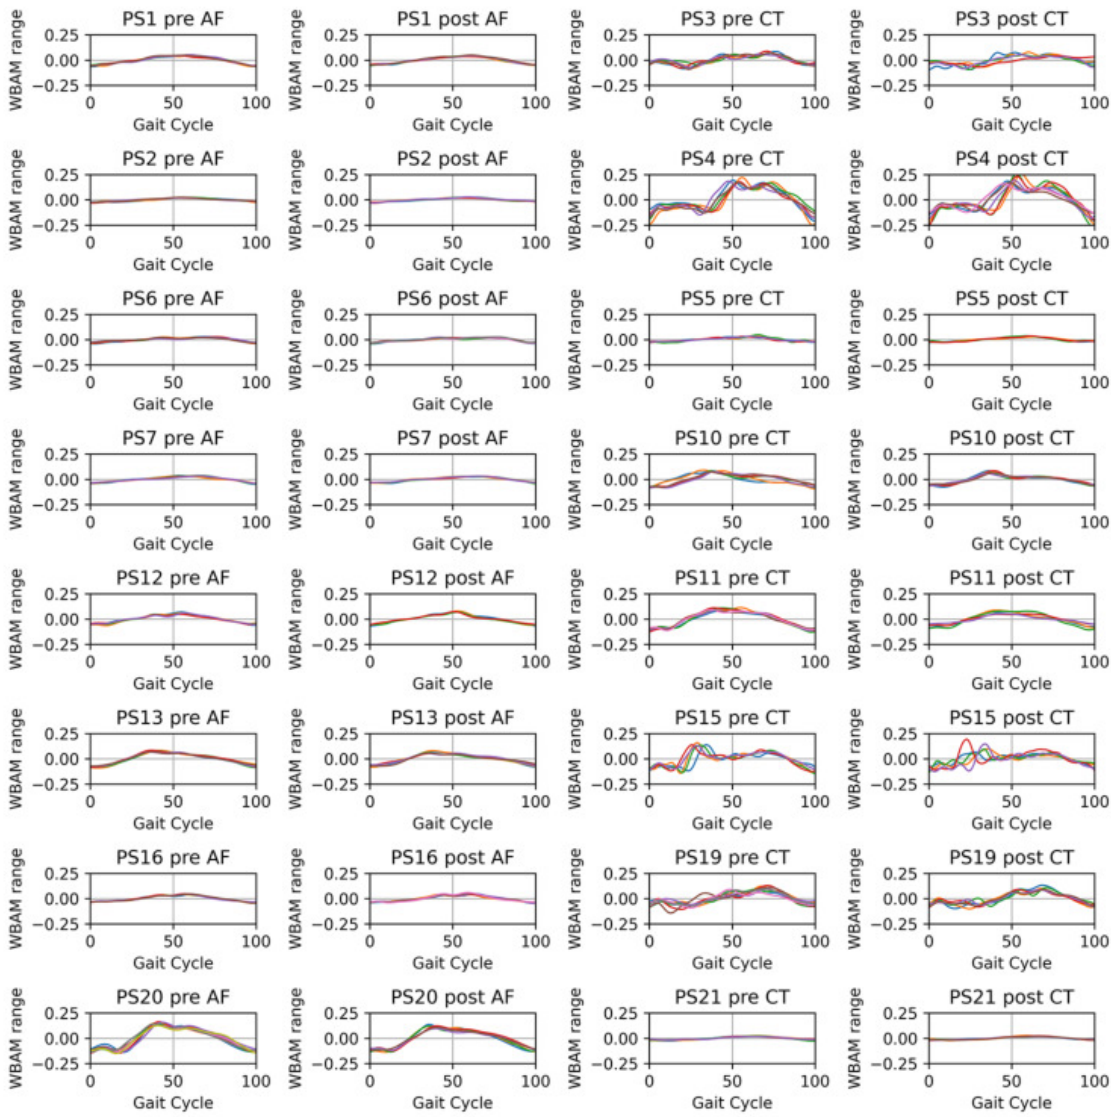
Figure 3. Frontal WBAM during one gait cycle for each patient on before (pre) and after (post) the training. From left to right, each panel indicates the precondition of the AF group, postcondition of the AF group, precondition of the CT group, and postcondition of the CT group. The positive direction of the vertical axis indicates the angular momentum around the CoM toward the non-paretic side. Gait cycle was set to 0% (100%) at the timing of the ground contact of the paretic foot. PS{} indicates the patient’s identification